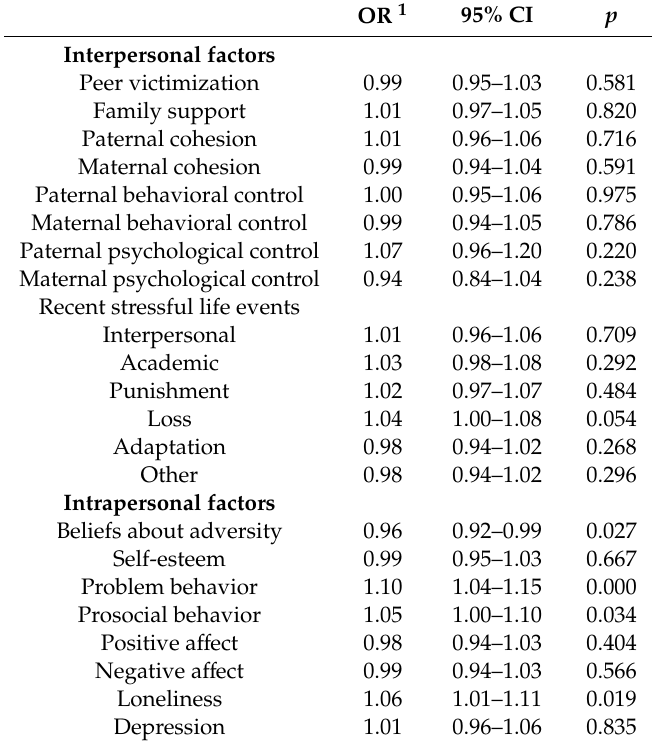
Table 3. Associations between predictors and NSSI initiation in the multi-predictor model. OR 1 95% CI